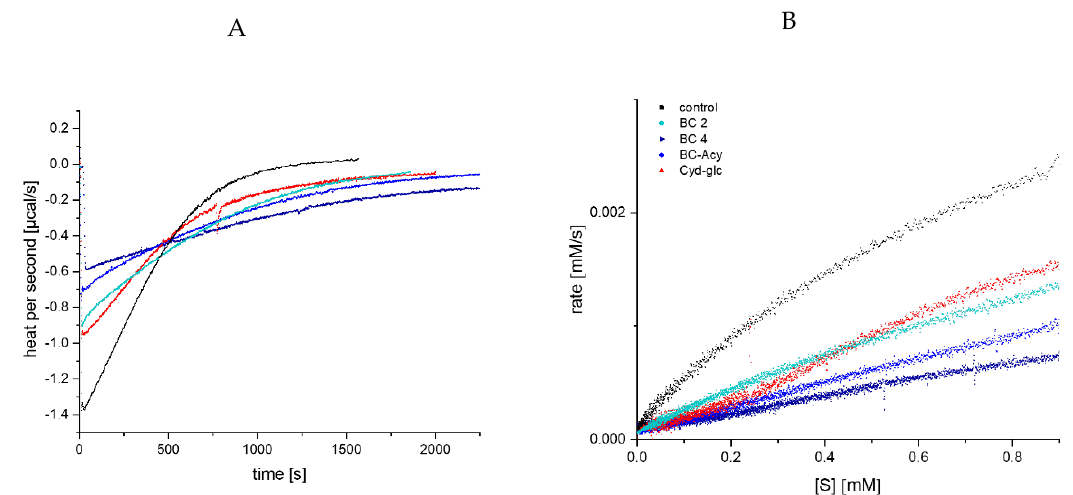
Figure 7. Thermogram for GalG 2 CNP conversion after addition of α -amylase in the presence of 100 µM black carrot anthocyanins ( A ), and respective Michaelis Menten plot ( B ), converted from (A). Abbr.: BC 2, Cyd-3-gal-xyl; BC 4, Cyd-3-gal-xyl-glc(fer); BC-ACY, the complex anthocyanin extract; Cyd-glc, Cyanidin-3-glucoside; [S], substrate concentration.